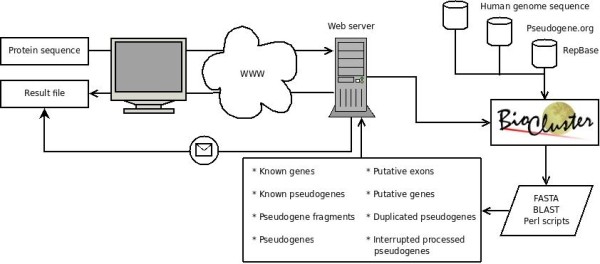
Layout of the PseudoGeneQuest service. The user initiates the search by providing a protein sequence on the web page. The analysis is performed on a cluster using databases, search programs and scripts. The results are mailed to the user, and deposited on the web server, where they can be accessed with the provided search ID.